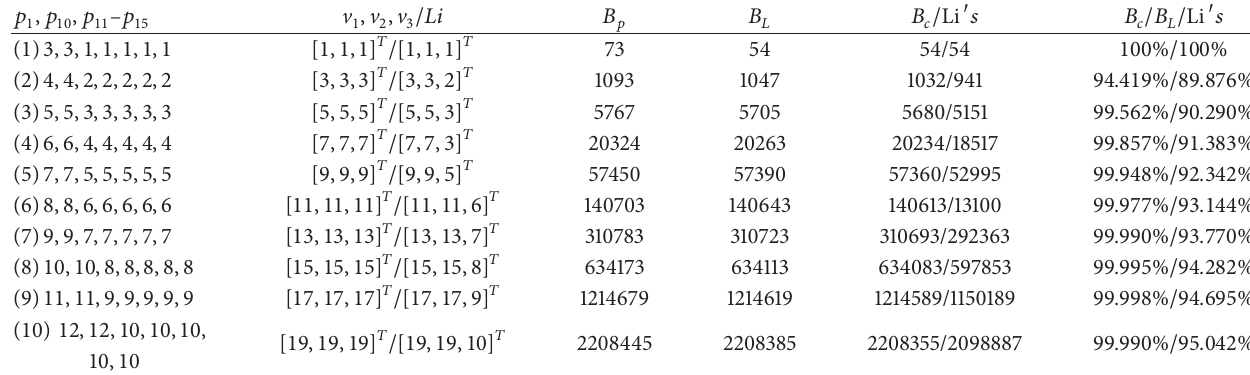
Table 1: Behavior permissiveness of the proposed deadlock prevention policy.